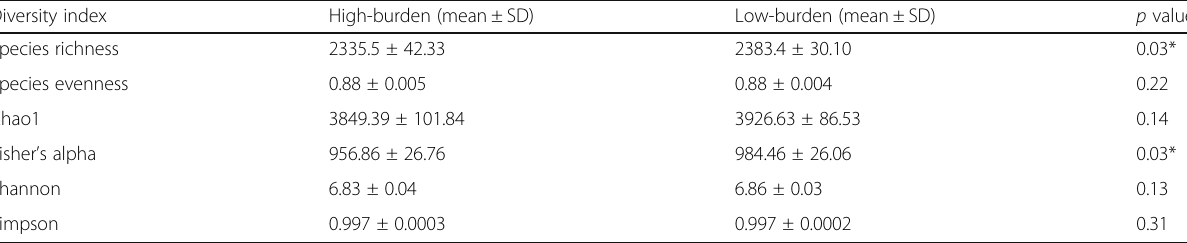
Table 1 Microbial diversity indices of the faecal microbiota of high and low parasite burden sheep